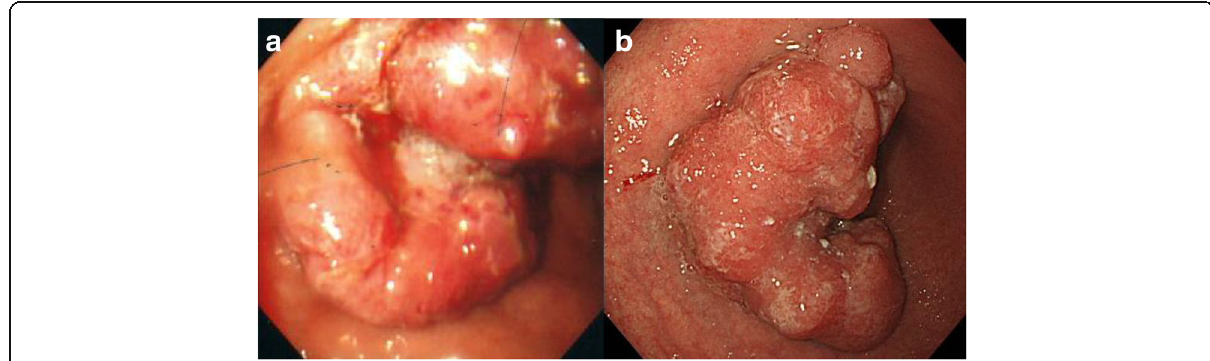
Fig. 1 Uppe r gastrointestinal endoscopy findings. a At the initial visit. Type III advanced GC was identified in the anterior wall of the lower gastric body. b Following chemotherapy. A portion of the primary tumor still